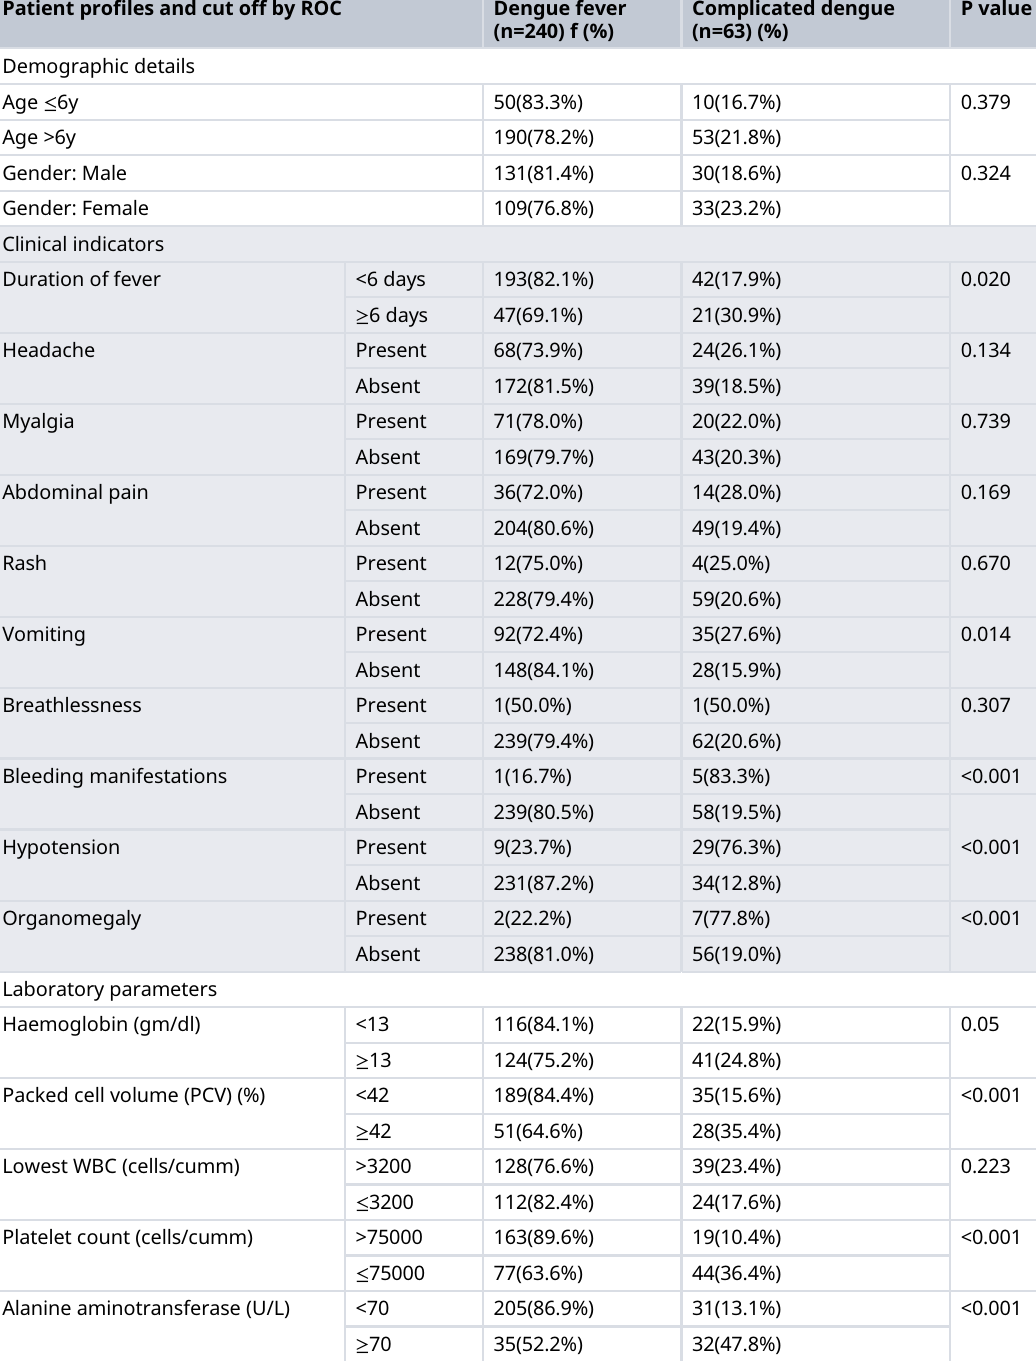
Table 1. Patient profiles in dengue fever and complicated dengue